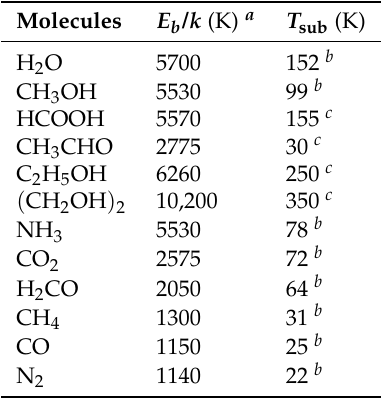
Table 2. Binding energies and sublimation temperatures for selected molecules on an ice surface. Molecules